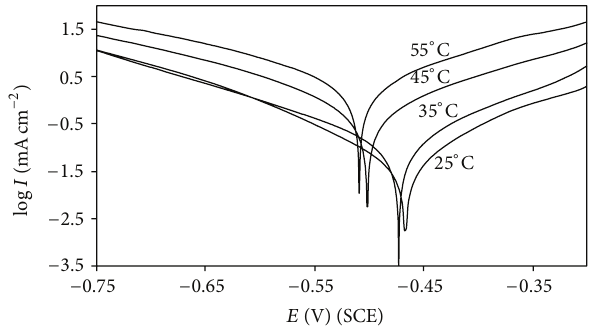
Figure 3: Effect of temperature on the cathodic and anodic responses for C38 steel in 1M HCl + 0.2mM of norharmane.